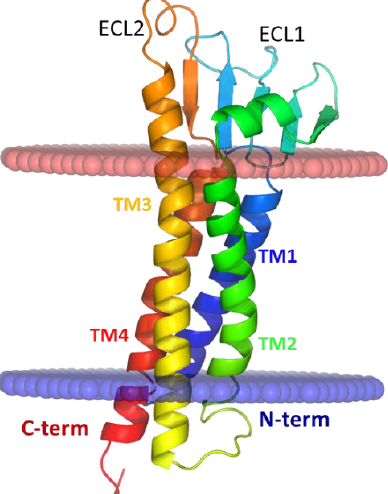
Figure 2. Homology modeled claudin-5 structure shows four transmembrane helices (TM1 − 4), extracellular loops (ECL1 and ECL2), and intracellular loop (ICL) in cartoon representation colored from N-terminal (blue) to truncated C-terminal (red). The membrane spanning region lies within the horizontal (red and blue) planes.